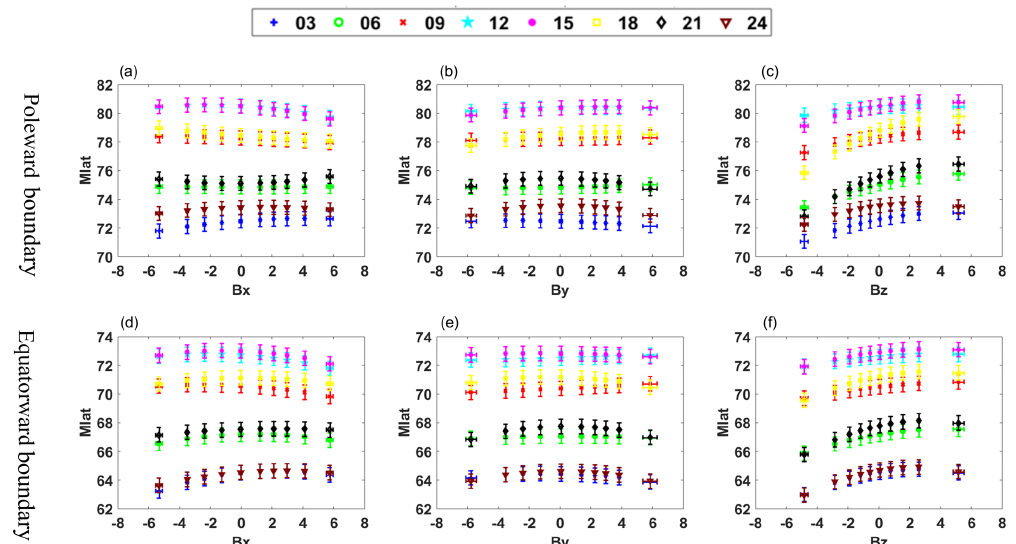
Figure 5. Responses of the magnetic latitudes of the poleward (a, b, c) and equatorward (d, e, f) boundaries to B x , B y , and B z respectively at 00:30, 00:60, 00:90, 12:00, 15:00, 18:00, 21:00, and 24:00MLT.